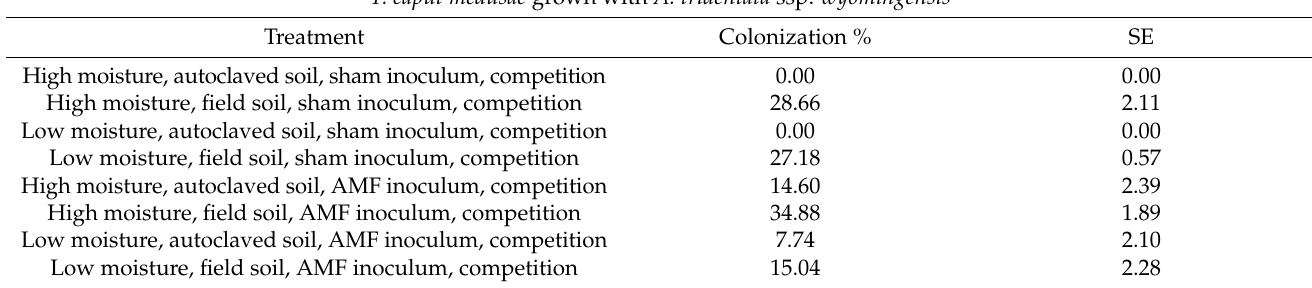
Table 3. Mean percentages and SE of AMF colonization in roots of Taeniatherum caput-medusae grown for 6 months in different soil, moisture, inoculum treatments, and associated Artemisia